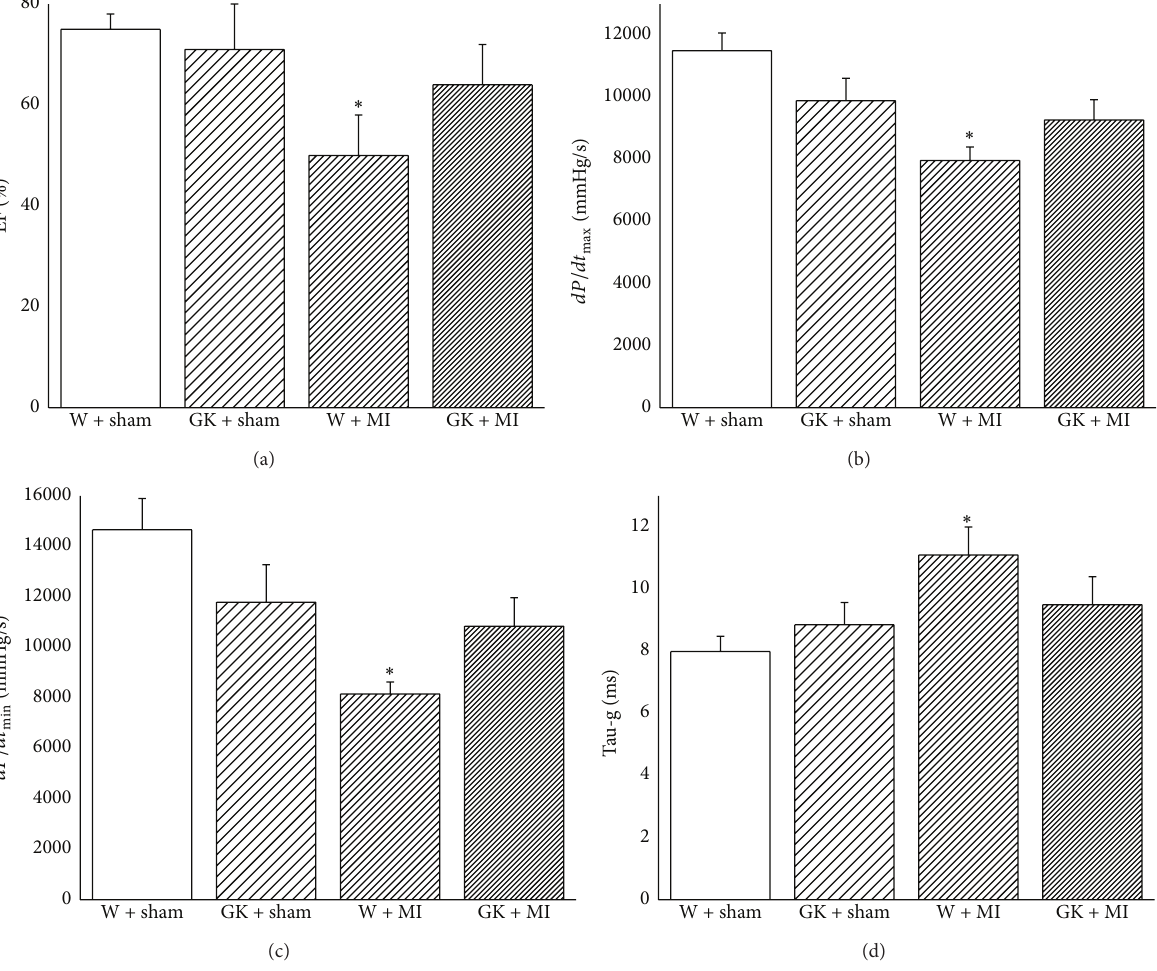
Figure 3: Left-ventricular systolic and diastolic function. Assessment of (a) ejection fraction, (b) maximal slope of the systolic pressure increment 𝑑𝑃/𝑑𝑡 max , (c) maximal slope of the diastolic pressure decrement 𝑑𝑃/𝑑𝑡 min , and (d) time constant of left-ventricular pressure decay Tau-g. Data is expressed as mean ± SEM. ∗ 𝑃 < 0.05 versus W + sham. MI indicates myocardial infarction; GK: Goto-Kakizaki; W: